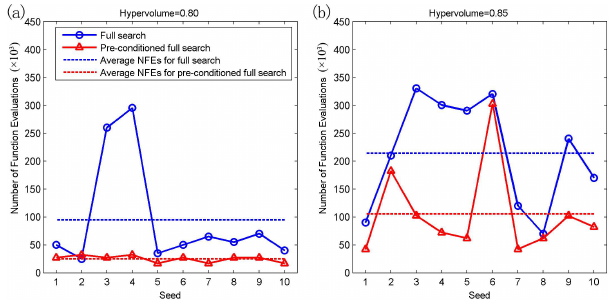
Figure 8. Optimal rule curves for different solutions: (S0) industry- favouring solution, (S1) agriculture-favouring solution, and (S2) compromised